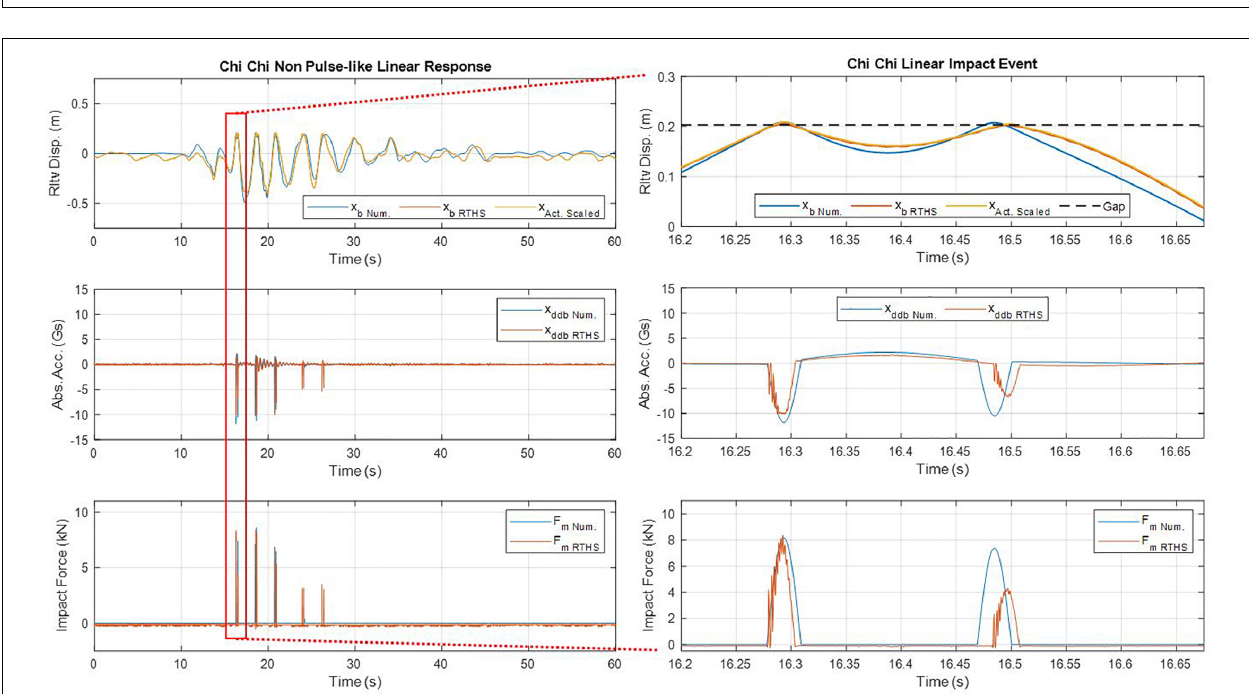
FIGURE 8 | Time history of the response to the Chi Chi non-Pulse-like ground motion for the linear impact scenario.